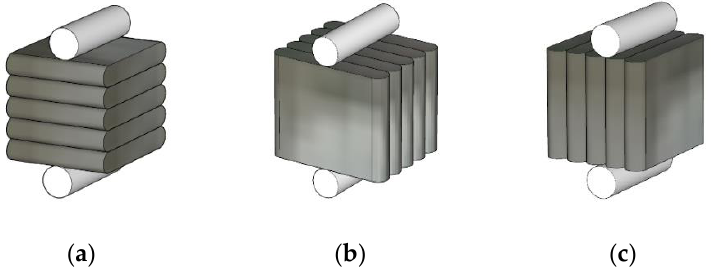
Figure 12. Splitting tensile strength tests with different loading directions. ( a ) Direction I; ( b ) Direction II; ( c ) Direction III.